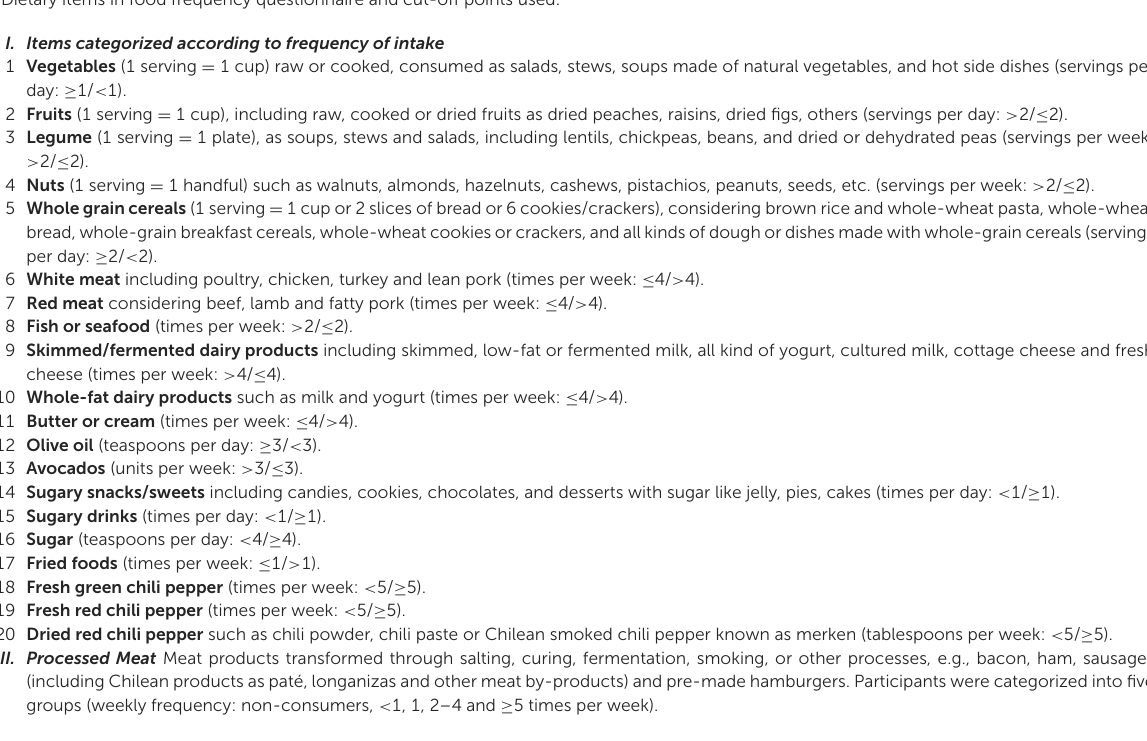
BOX1 Dietary items in food frequency questionnaire and cut-off points